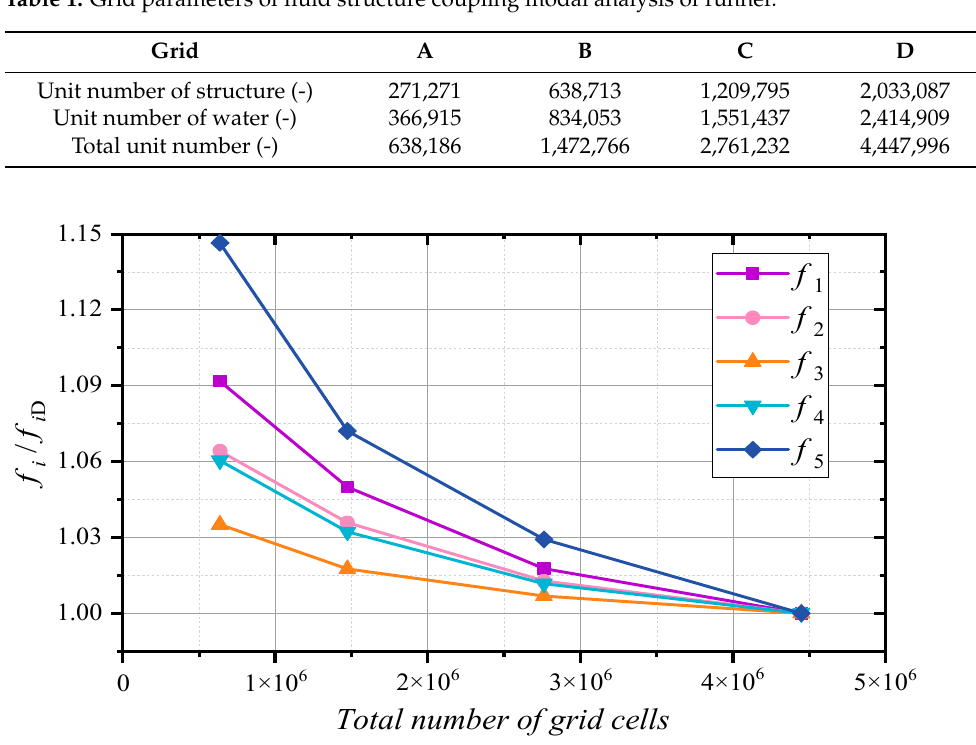
Table 1. Grid parameters of fluid structure coupling modal analysis of runner.